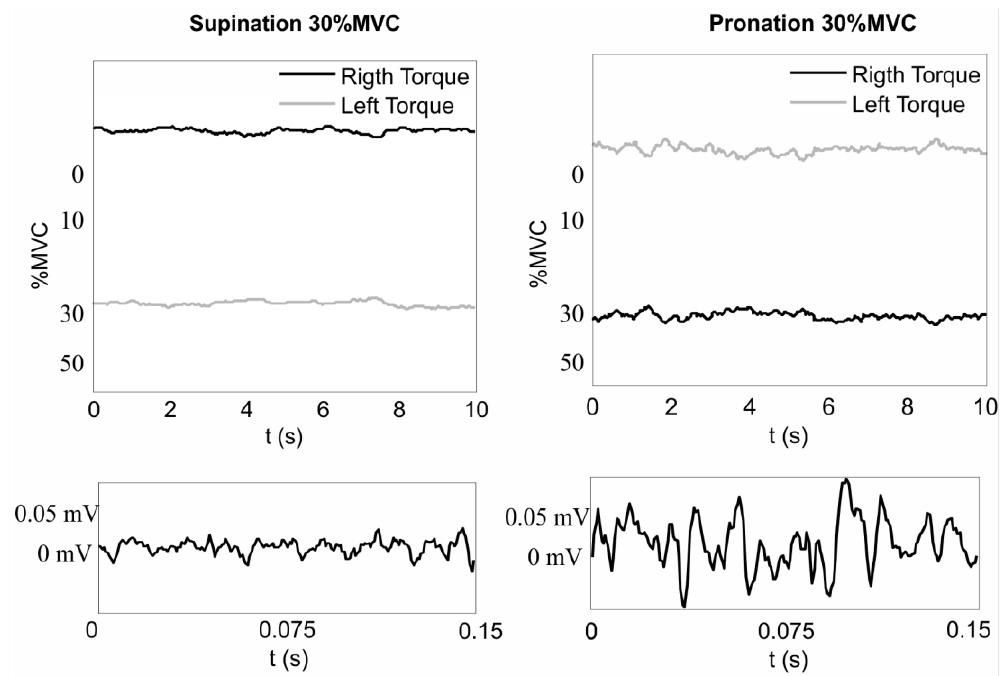
Figure A1. Example of torque and EMG signals in supination and pronation in one subject. Left. Supination at 30% MVC. The exerted torque on right (black) and left (gray) sides of the mechanical brace are shown at the top of the figure. The sEMG signal recorded on one of the channels of the Pronator Teres muscle is shown at the bottom. Rigth. Torque signals for Pronation at 30% MVC are shown on the top of the figure. The sEMG signal recorded on the same channel as in the previous case is shown at the bottom.